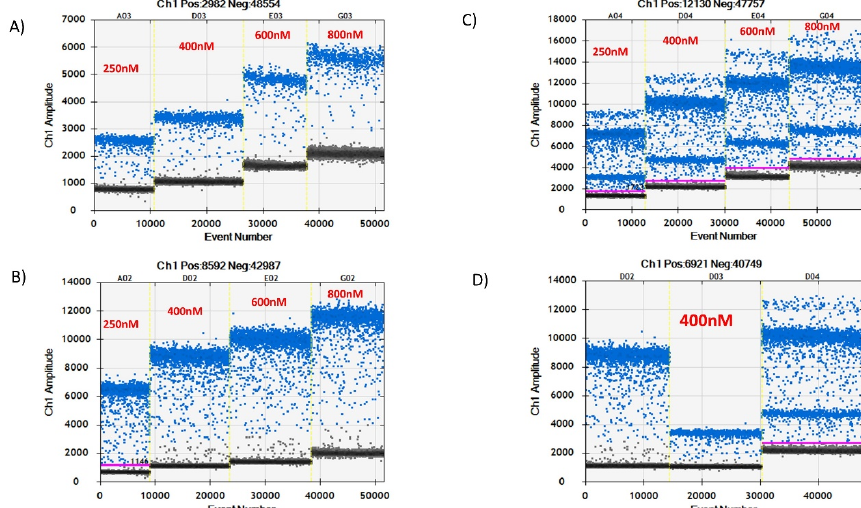
Figure 4. Simplex and duplex assay probe concentration (250 nM, 400 nM, 600 nM, and 800 nM) test results. A and B represent simplex assays results of IS1081 and IS6110 genes, respectively, at different probe concentrations ranging from 250 nM to 800 nM. C represents duplex assay results. D shows the result of the optimal concentration chosen for further experiments.